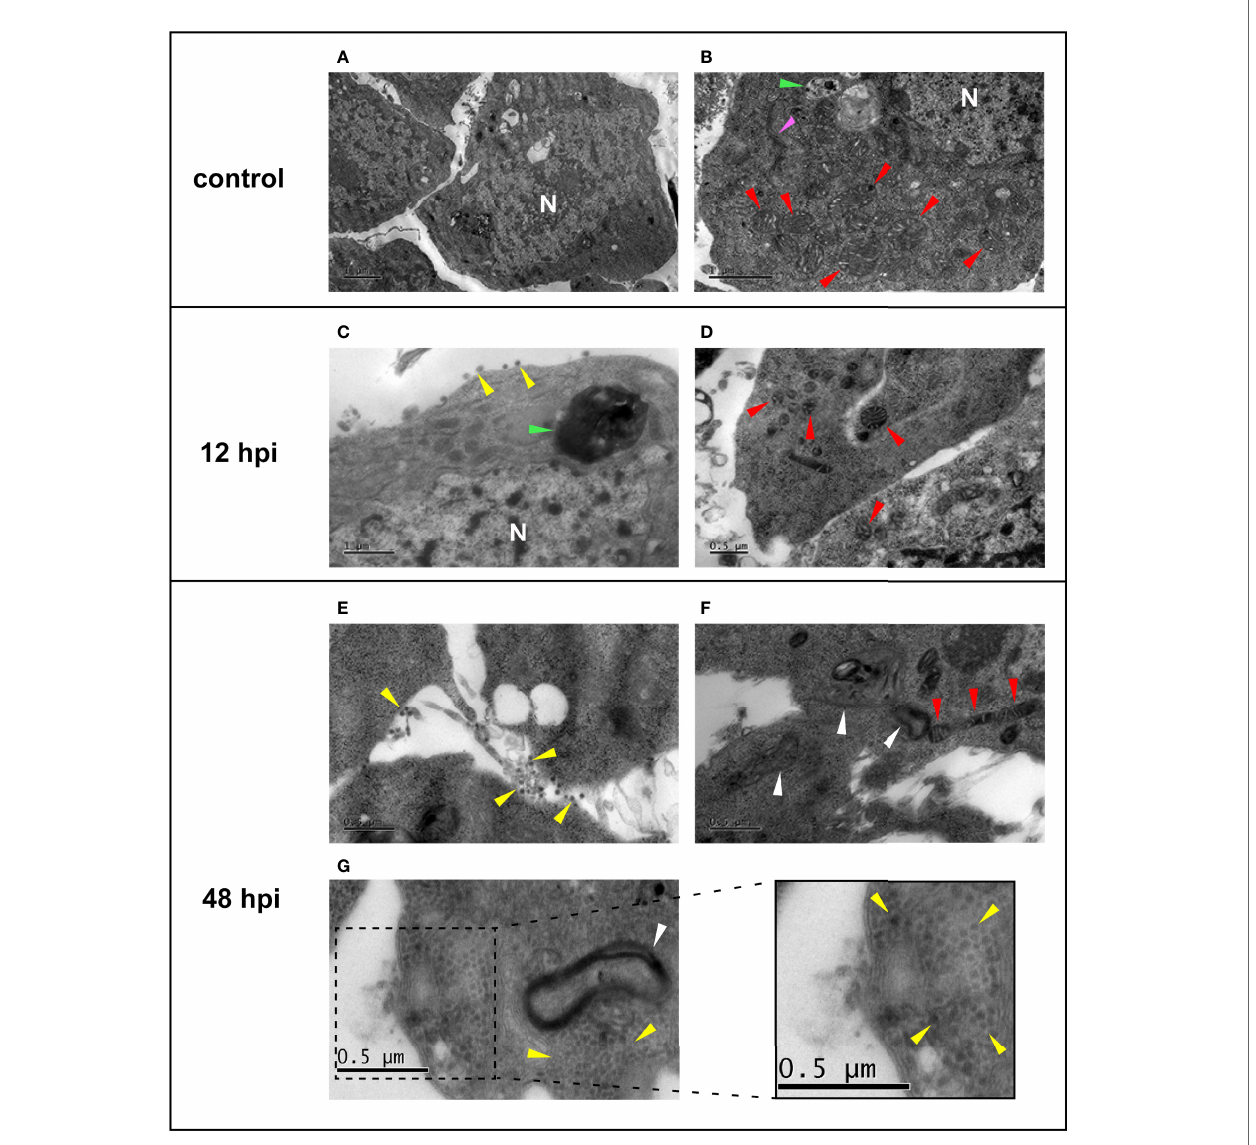
FIGURE 3 | Electron micrographs of uninfected (A, B) and chikungunya virus (CHIKV)-infected (C – G) Aag-2 cells. (A, B) Uninfected cells showing the mitochondria (red arrows), autophagic vesicle (green arrow), a possible Golgi complex (pink arrow), and the nucleus (N). (C, D) Aag-2 cells infected with CHIKV using multiplicities of infection (MOIs) of 0.1 at 12 hpi. (C) Possible released viral particles can be seen in the extracellular space (yellow arrows), and the proposed autophagic vesicle is darker (green arrow). Mitochondria (red arrows) and the nucleus (N) membranes are apparently still preserved. (E – G) Aag-2 cells infected with CHIKV at 48 hpi using MOI of 0.1 showing possible virions (yellow arrows) found in both extracellular (E) and intracellular spaces (G) , inset, while mitochondria present a suggestive abnormal elongated morphology (red arrows) (F) , and membrane residues are observed (white arrows), probably associated with cytopathic effect (CPE) (F, G) . Bars represent 1 m m in (A – C) and 0.5 m m in all other